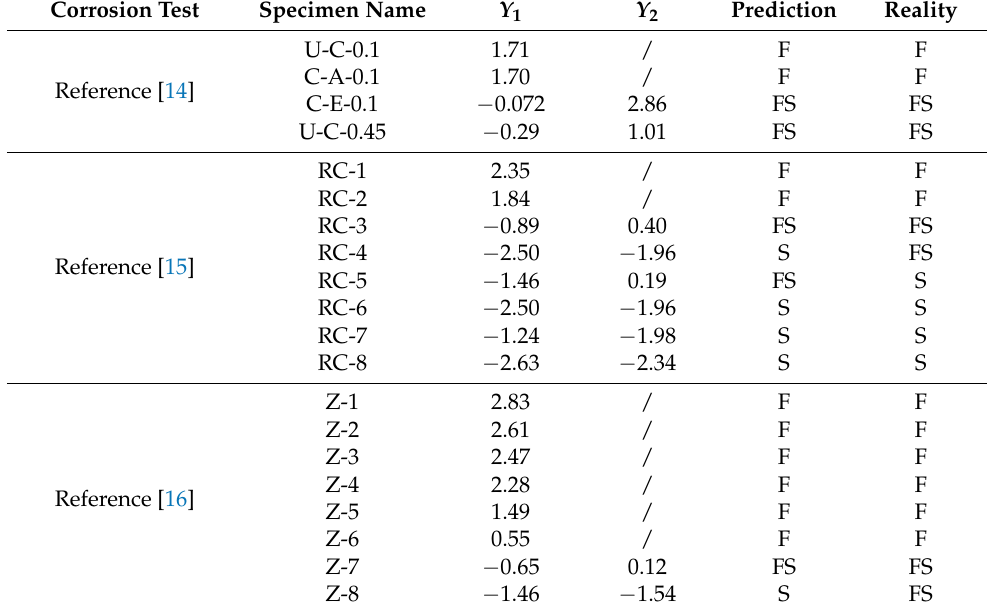
Table 4. Identification results of corroded